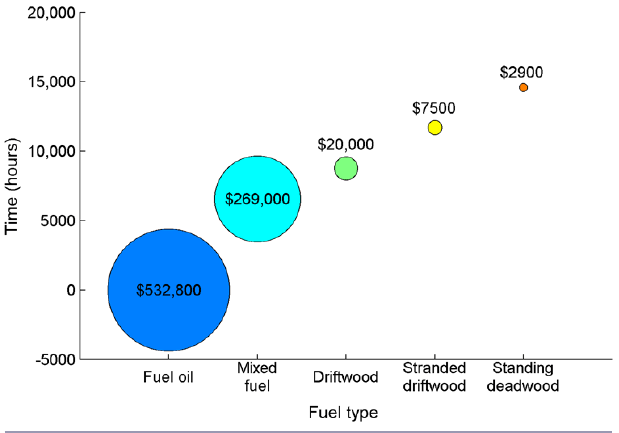
Fig. 6 . Estimated costs, i.e., financial and time, associated with the harvest of the average modeled wood deficit, 730 cords, from 2007 to 2013 using each fuel type alone versus a mix of 25% stranded driftwood, 25% standing deadwood, and 50% fuel oil. The size of the bubble is proportional to the estimated financial cost, rounded to the nearest $100 U.S. dollars. Time costs include the time required to gather and process